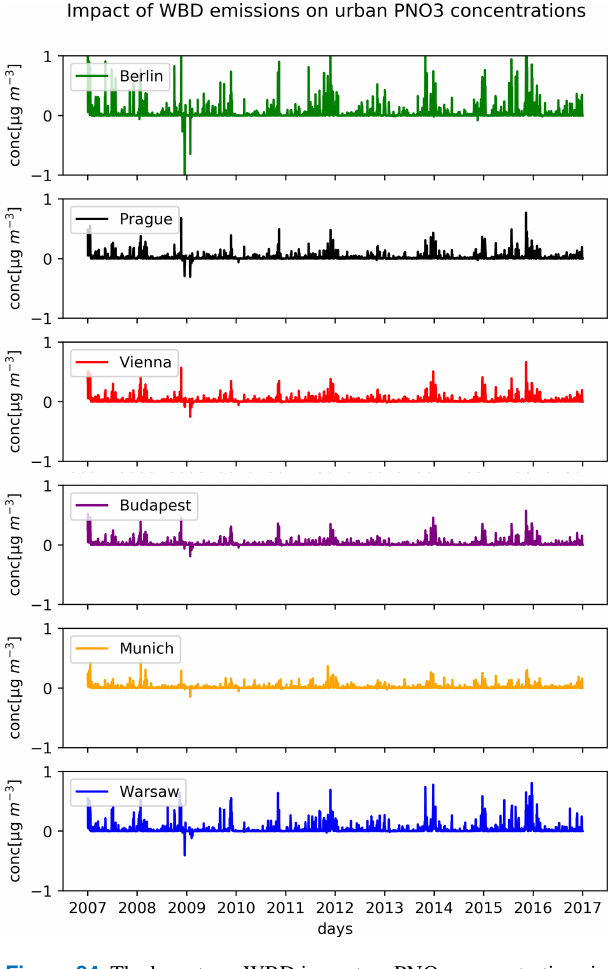
Figure 24. The long-term WBD impact on PNO 3 concentrations in ISORROPIA, averaged daily for 2007–2016. Units are micrograms per cubic